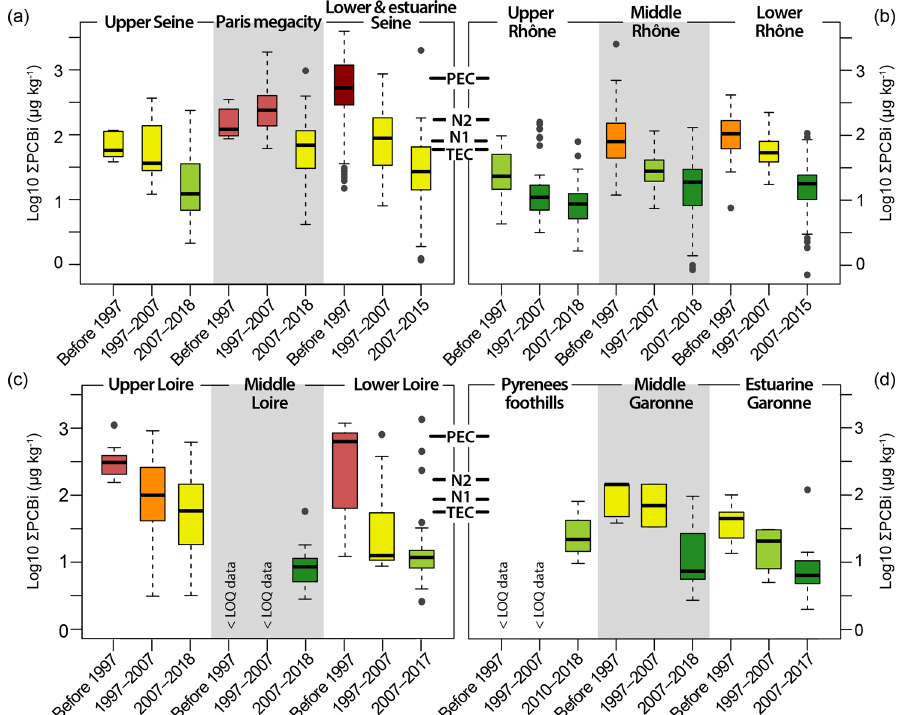
Figure 4. Detailed spatio-temporal distribution of (cid:54) PCBi (log10 scale) in the (a) Seine, (b) Rhône, (c) Loire and (d) Garonne. Colours describe pollution levels in sediments, ranked from forest green (lowest levels) to dark red (highest levels). TEC, PEC, N1 and N2 refer to the main thresholds for PCBs: TEC (threshold effect concentration) and PEC (probable effect concentration) are 59.8 and 676µgkg − 1 for total PCBs, respectively (MacDonald et al., 2000); French regulatory levels N1 and N2 refer, respectively, to 80 and 160µgkg − 1 of (cid:54) PCBi (order of 17 July